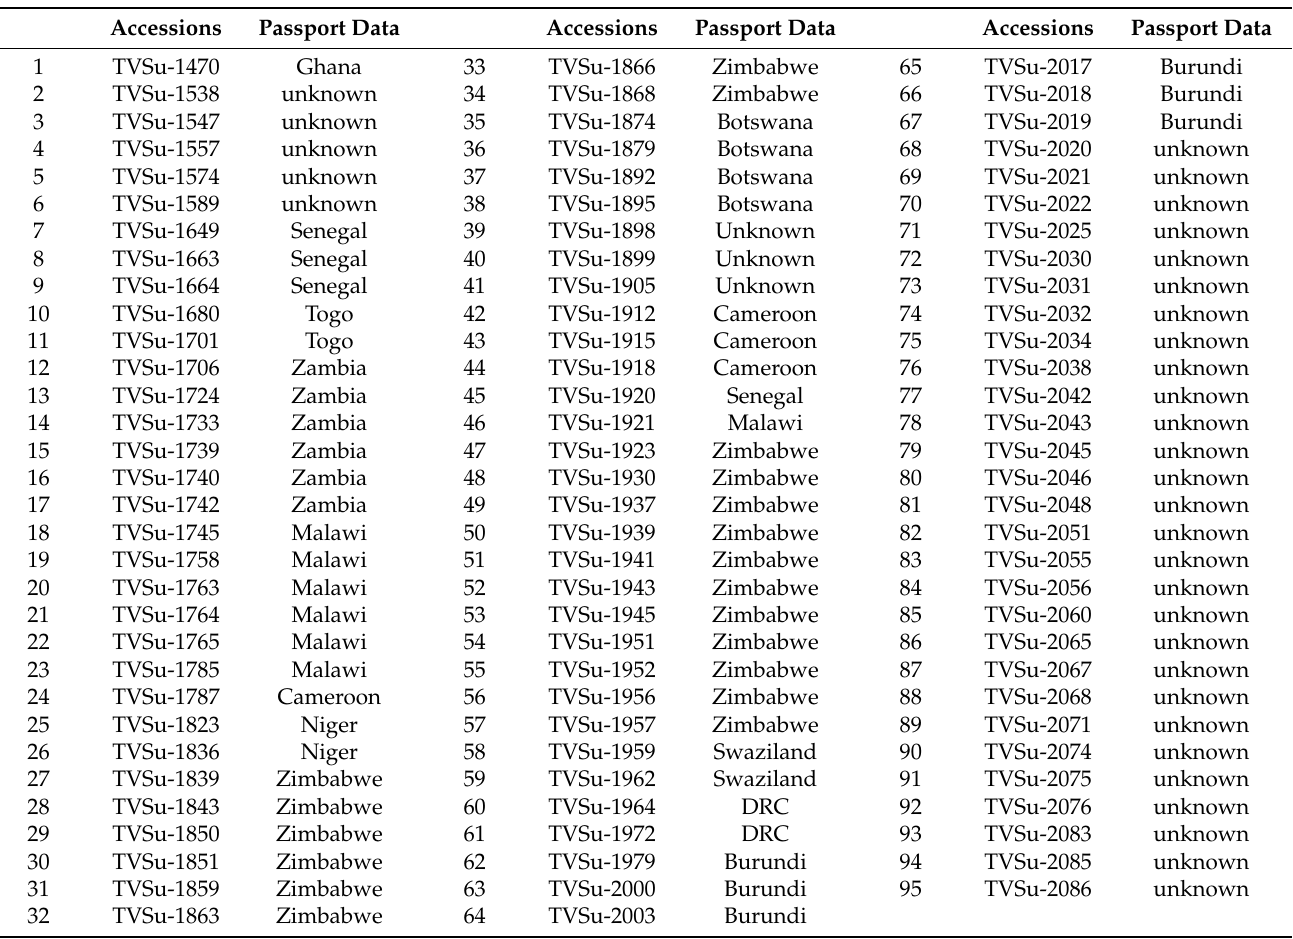
Table 2. Bambara groundnut accessions and their